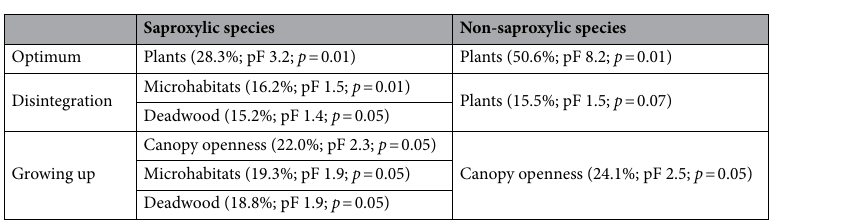
Table 2. Table of variables that best explained species preference in each stage